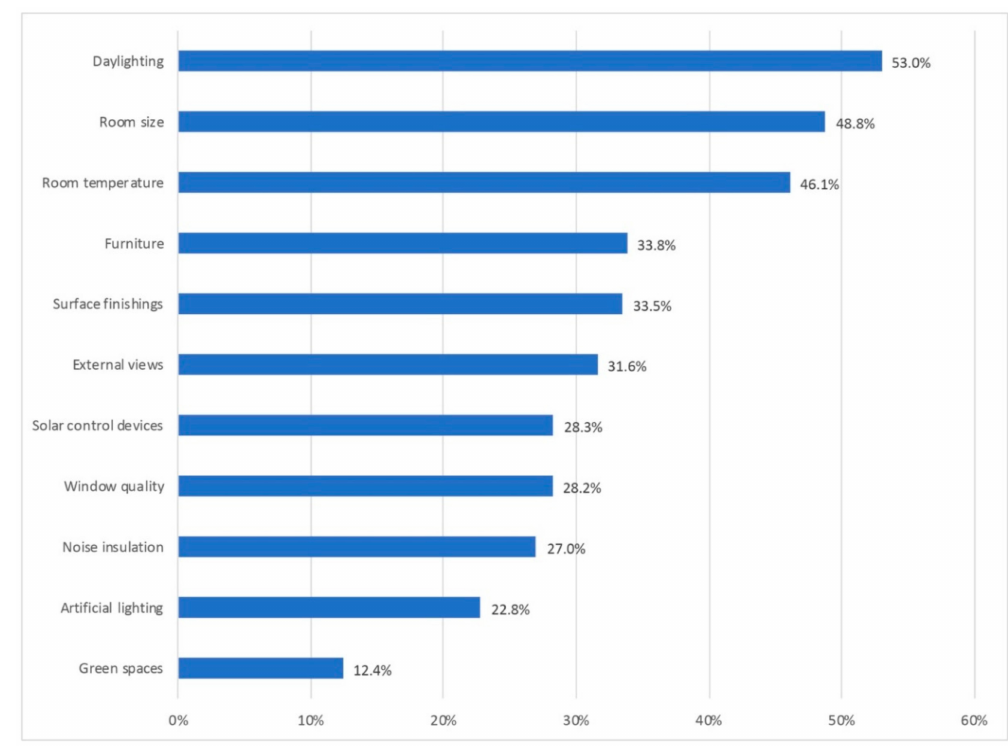
Figure 5. Aspects valued as good/adequate of the workspace according to the participants.